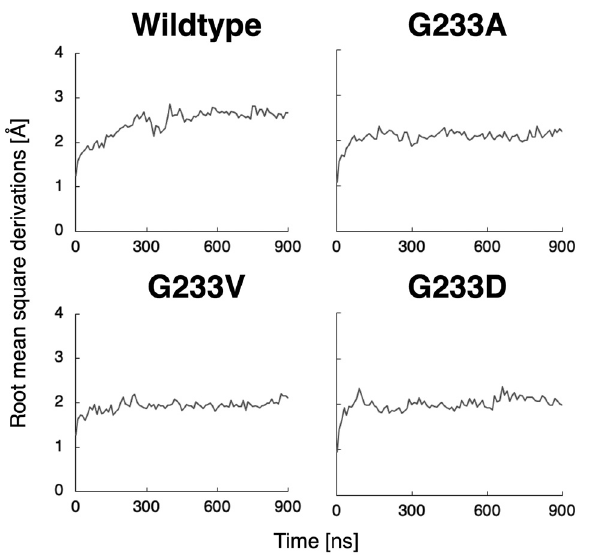
Fig. 2 Time-dependent changes in the root mean square deviations (RMSDs) of atoms constructing VWF and GPIb ɑ . The RMSDs of atoms constructing VWF and GPIb ɑ , excluding water molecules were cal- culated every 10 ns are shown in wild-type ( left upper panel ), G233A ( right upper panel ), G233V ( left lower panel ), and G233D ( right lower panel ).